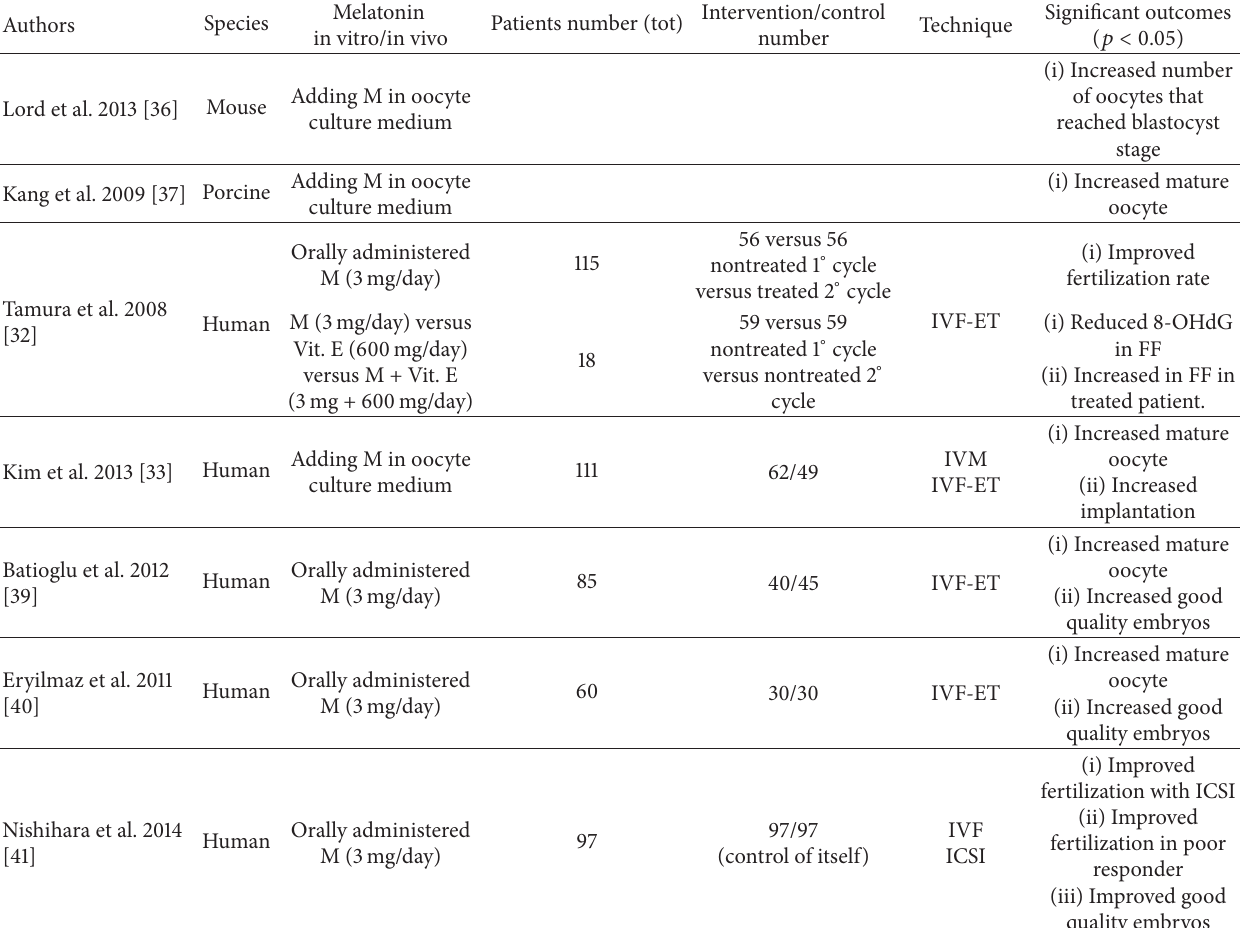
Table 1: Effects of melatonin supplementation therapy (adding in oocytes culture or orally administered to patients) during ART.